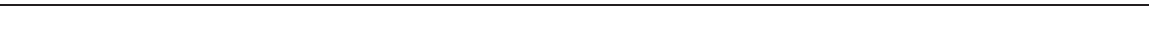
Fig. 7 p53 loss rescued the cellular phenotypes of SKO growth plates. a Growth plate of DKO mice shows decreased cell apoptosis, as indicated by TUNEL staining; the representative images are on the left and quanti fi cation on the right ( n = 3; error bars = standard deviation, * p < 0.05; NS not signi fi cant, Student ’ s t -test; scale bar = 100 μ m). b γ H2AX expression was not rescued in the growth plate of DKO mice. The upper panel shows the representative IHC on the RZ and PZ of growth plate with quanti fi cation on the right; the lower panel shows western blots and quanti fi cation on the right ( n = 6, error bars = standard deviation, * p < 0.05, NS not signi fi cant, Student ’ s t -test; scale bar = 50 μ m). c Corrected cell proliferation by Ki67 staining in the growth plate of DKO mice relative to SKO mice (quanti fi cation shown in the low panel; n = 3, error bars = standard deviation, * p < 0.05, NS not signi fi cant, Student ’ s t -test; scale bar = 50 μ m). d Corrected cell senescence in Ad-Cre-mediated-DKO vs SKO primary rib chondrocytes, as indicated by SA- β -gal